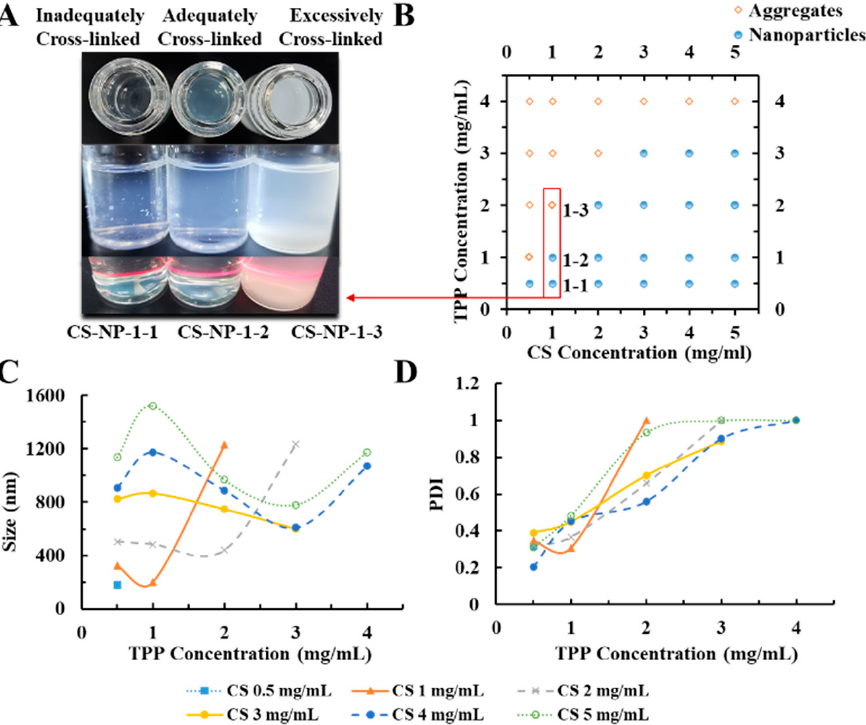
Figure 1. ( A ) The appearances of the chitosan nanoparticles (CS-NPs) in different conditions (Inade- quately/Adequately/Excessively Cross-linked); ( B ) effect of tripolyphosphate (TPP) and CS